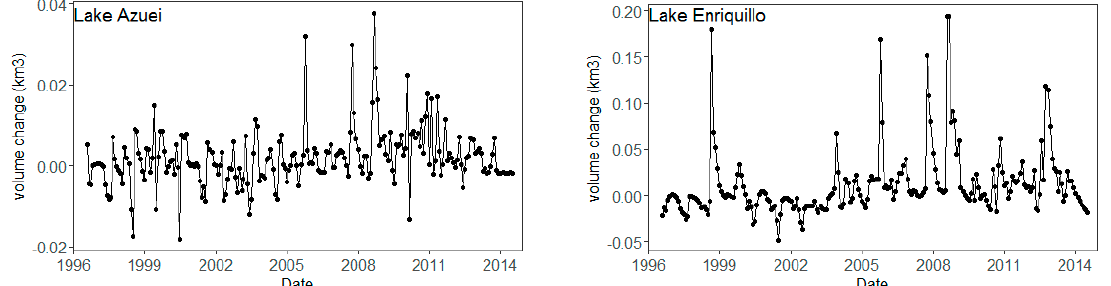
Figure 7. Monthly imputed volume change time series of both Lakes (km 3 ).